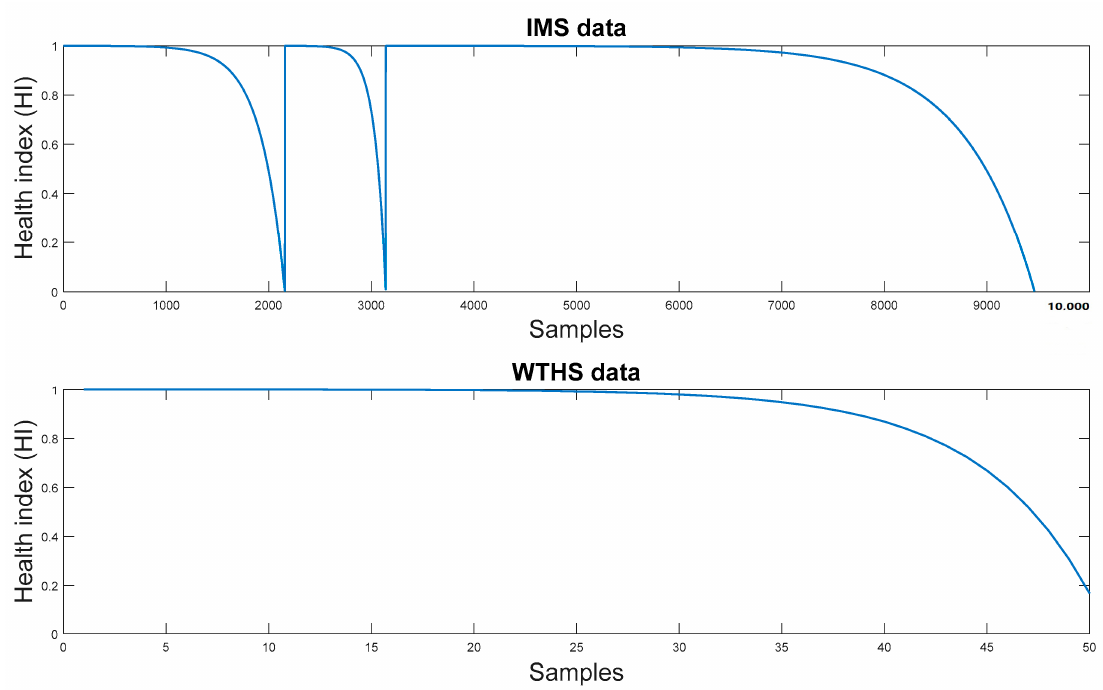
Figure 7. Given health indexes for each deterioration path.